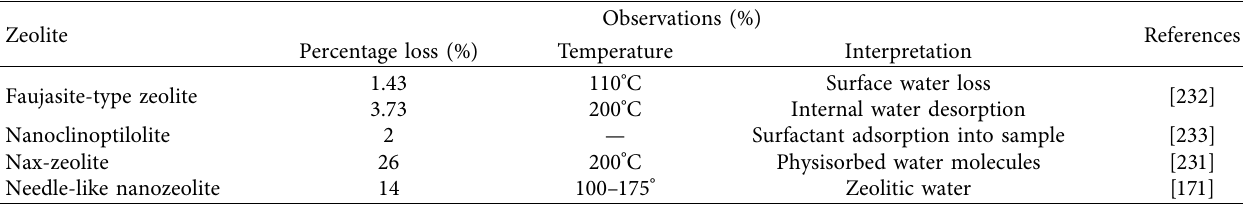
Table 8: Summary of the TGA analysis of zeolites.